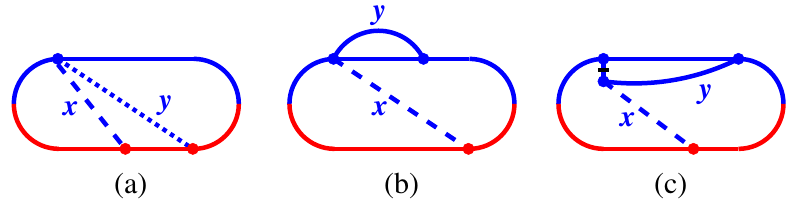
Figure 13 . Examples of diagrams that involve 4-gluon or LCPT instantaneous vertices, which have been left out of our